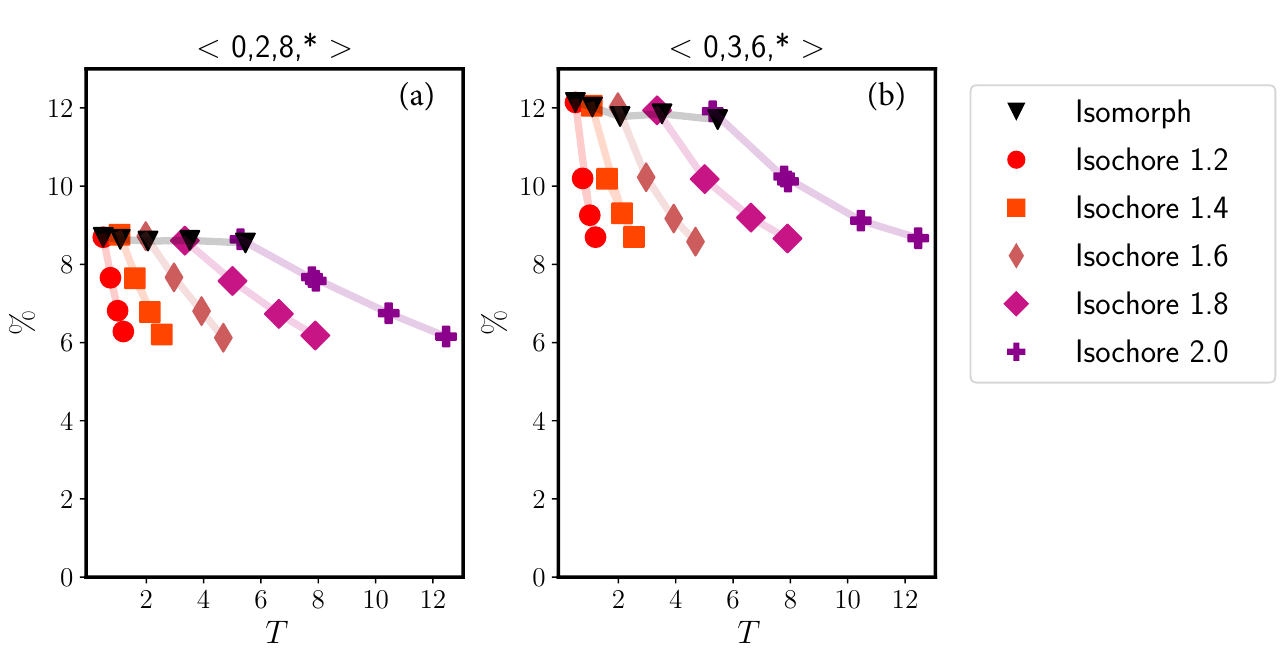
Figure 7. Two Voronoi structures of the KA system probed along the reference state point ( ρ , T ) = ( 1.20,0.50 ) isomorph and along several isochores, plotted as a function of the temperature. ( a ) shows results for the < 0,2,8, ∗ > Voronoi structure around either an A or a B particle, and ( b ) shows analogous results for the < 0,3,6, ∗ > Voronoi structure. While there is significant variation along the isochores, both structures are isomorph invariant to a good